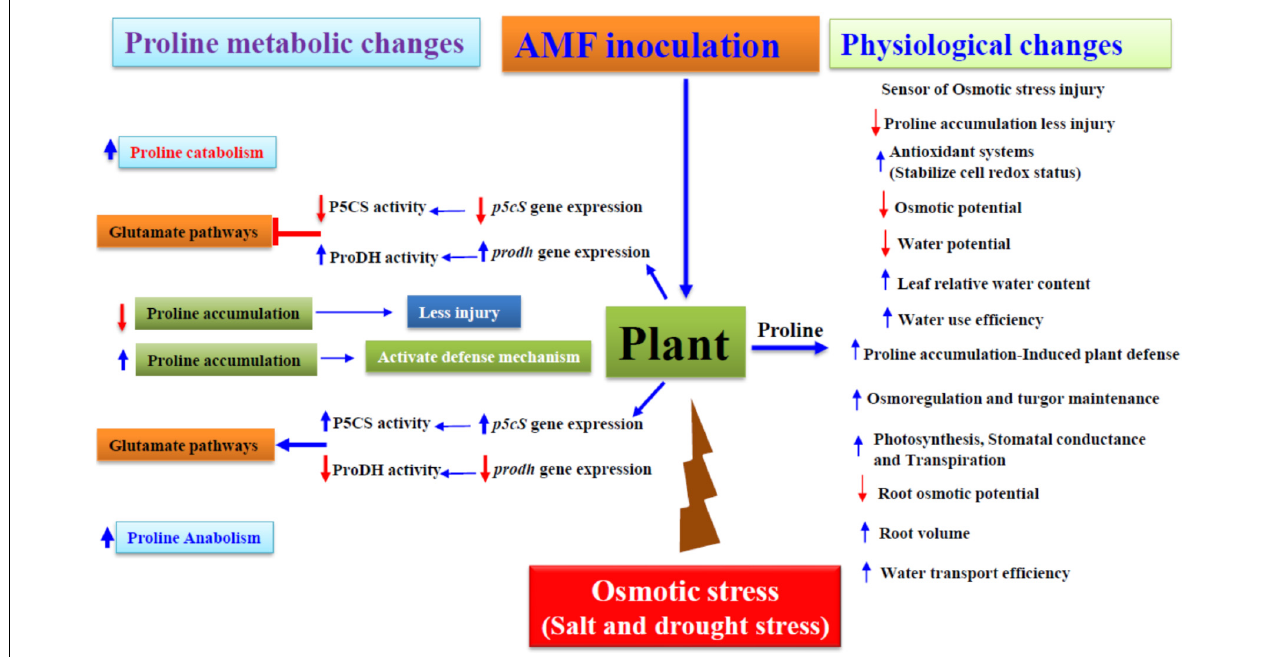
FIGURE 1 | Proline accumulation influenced physiological and molecular changes by osmotic stress in Arbuscular Mycorrhizal symbiotic plants. P5CS- (cid:49) 1, pyrroline-5-carboxylate synthetase; ProDH, proline dehydrogenase. The blue arrows indicate increase/up-regulation, while the red arrows indicate decrease/down-regulation. , inhibition and induction,